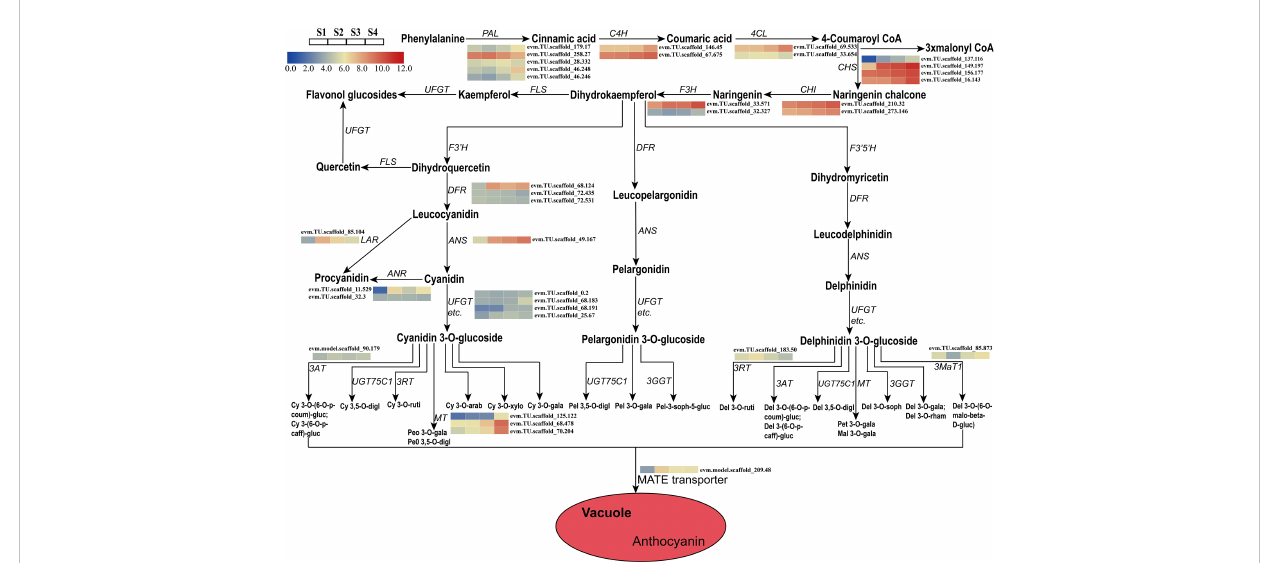
FIGURE 4 Expression analyses of structural genes involved in the pathway of anthocyanin biosynthesis at four developmental stages in the sepal were evaluated by RNA-Seq. Cy, cyanidin; Peo, Peonidin; digl, diglucoside; gluc, glucoside; coum, coumaroyl; caff, caffeoyl; ruti, rutinoside; gala, galactoside; arab, arabinoside; xylo, xyloside; Pel, Pelargonidin; soph, sophoroside; rham, rhamnoside; malo, malonyl; Pet, Petunidin; Mal, Malvidin; Del, Delphinidin.